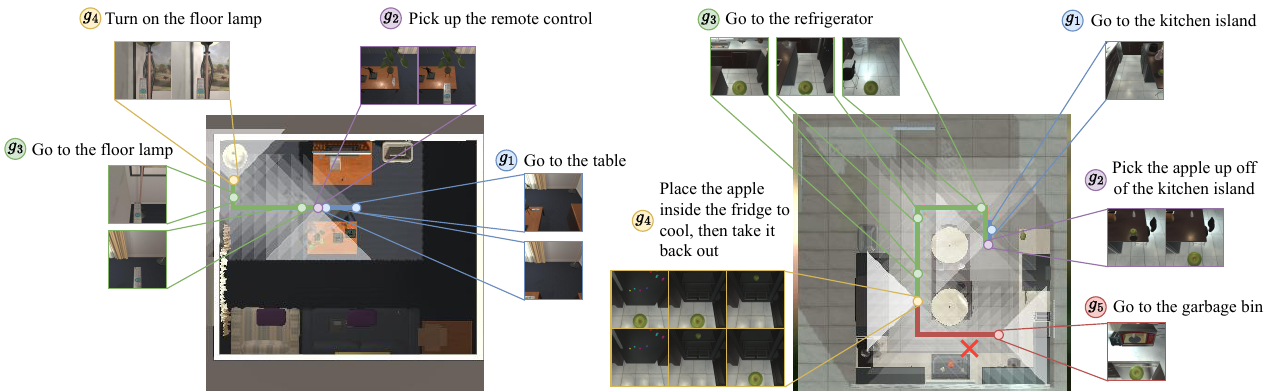
Figure 6. Qualitative results of online evaluation. Success ( left ) and failure ( right ) cases are shown for the agent navigating and manipulating objects to reach the task goal I